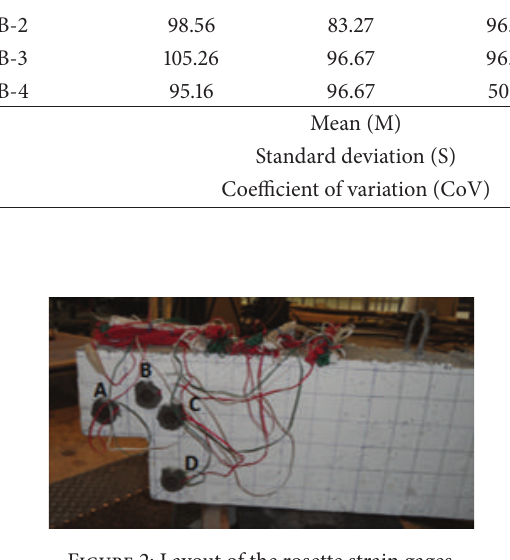
Figure 2: Layout of the rosette strain